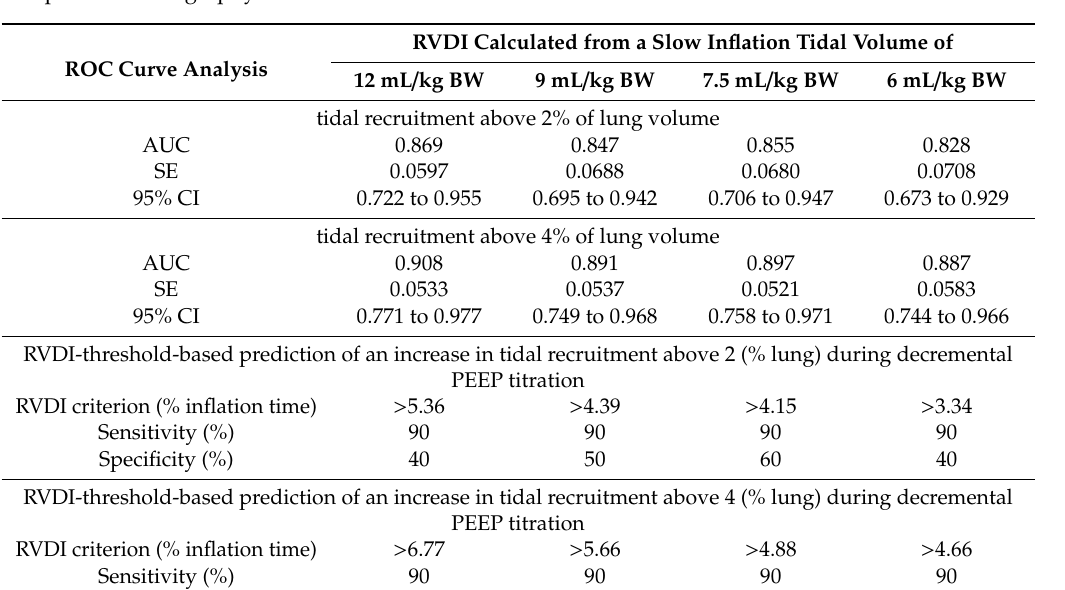
Figure 6. Receiver-Operator-Characteristic (ROC) curve analyses to estimate sensitivity and specificity of certain RVDI values in predicting an increase of tidal recruitment above ( A ) 2% or ( B ) 4% of the total lung volume with decreasing PEEP. Analyses were performed for RVDI values calculated from slow inflation tidal volumes of 12 (blue), 9 (green), 7.5 (yellow), and 6 (doted) mL / kg. Quantitative analyses are given in Table 3. Table 3. Receiver-Operator-Characteristic curve analyses to predict tidal recruitment from electrical impedance